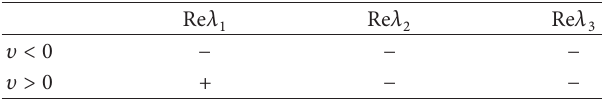
Table 1: Signs of real parts of eigen values of model (4) without time delay around interior equilibrium 𝑃 ∗